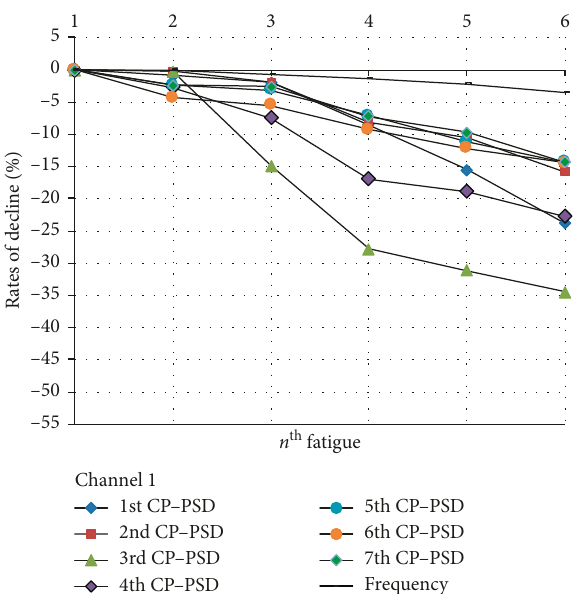
Figure 20: The declined rates in channel 1 with 7 central points in 4 fatigue levels.